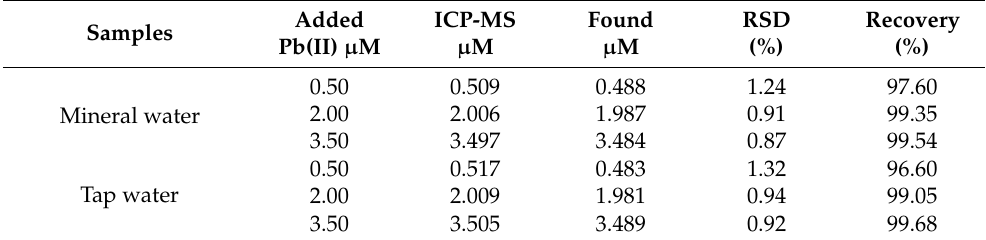
Table 1. Tracing of Fe(III) in real samples depending on Tryp-AgNCs ( n = 3). Added Samples Pb(II) µ M